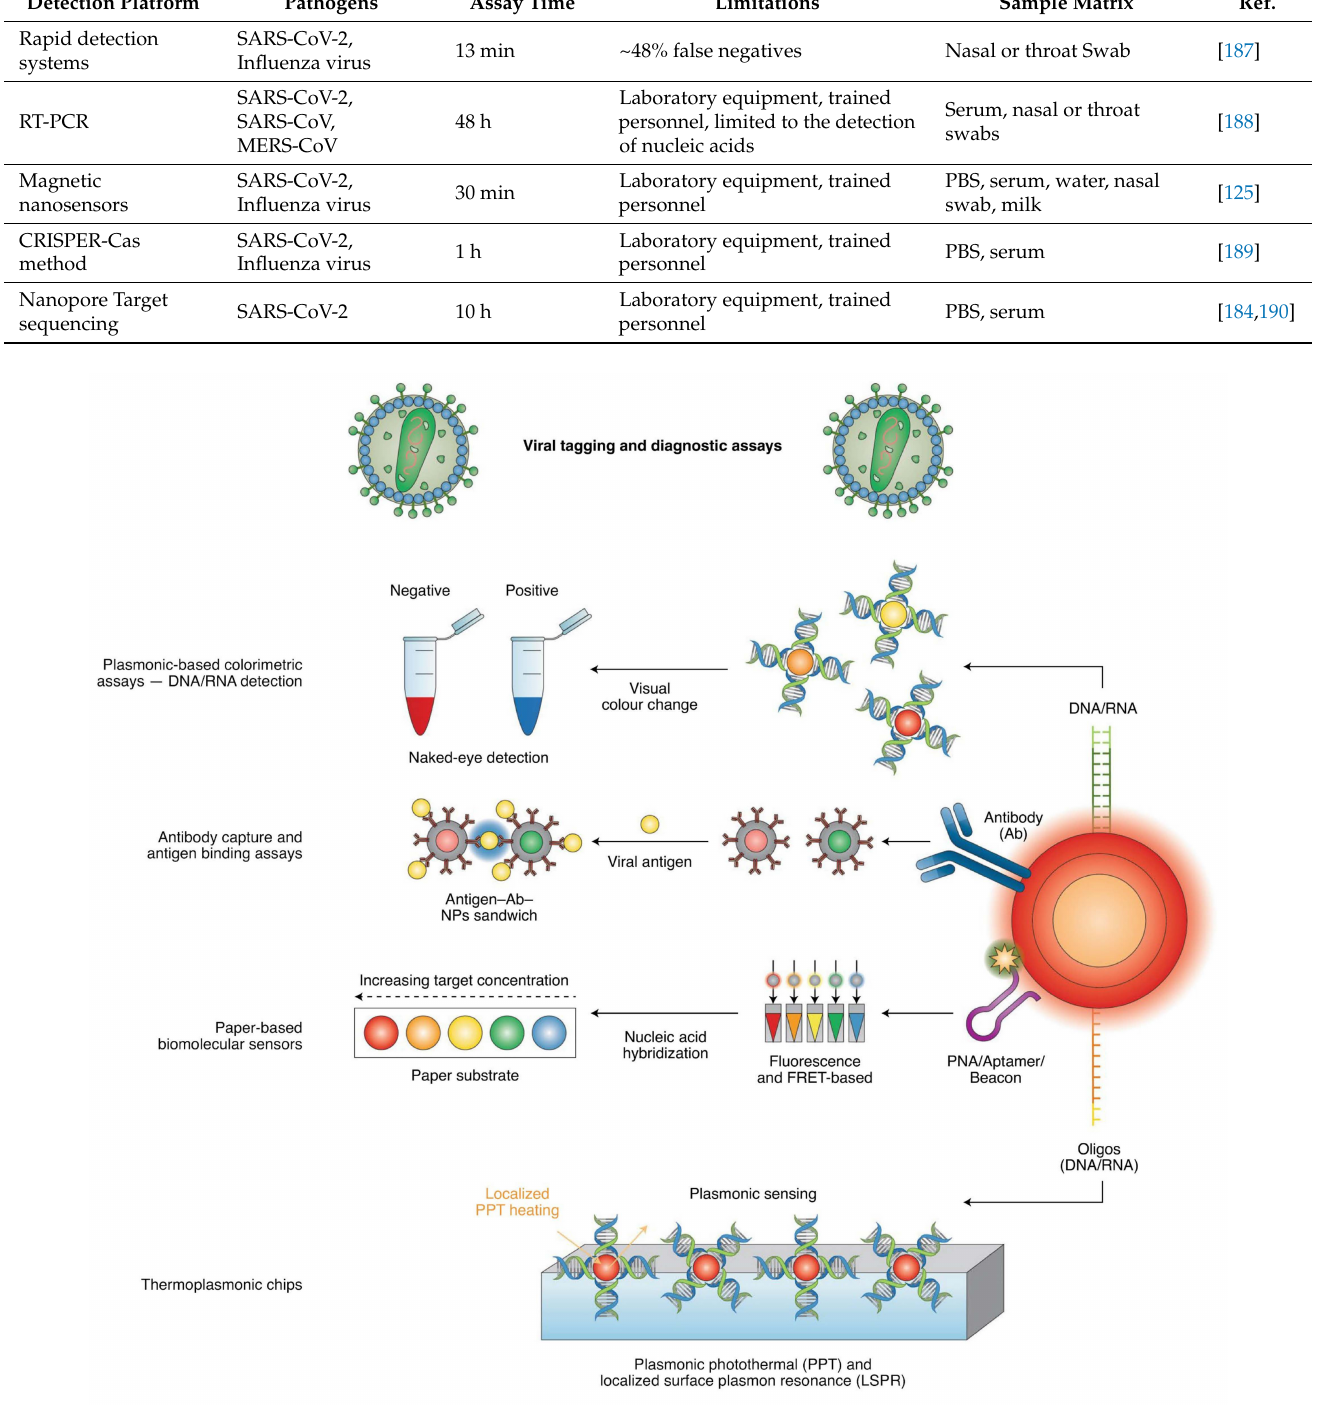
Table 4. Detection platforms for pathogenic infections.